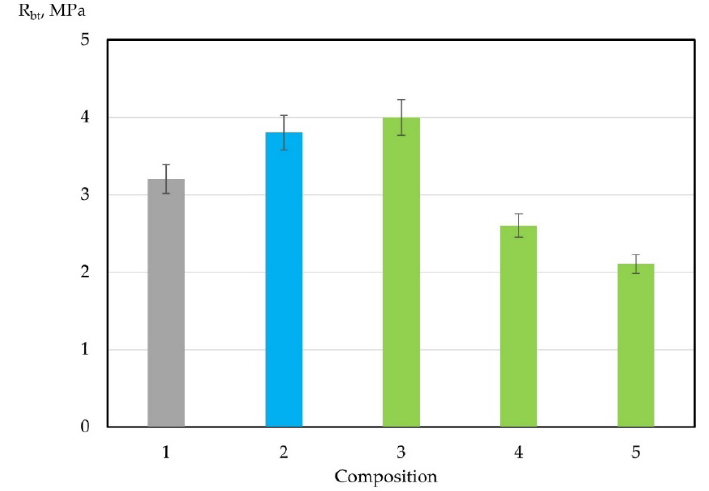
Figure 8. Change in axial tensile strength of concrete samples at the age of 28 days: 1 (grey)—control composition; 2 (blue)—electromagnetically treated cement paste without RSA; 3, 4, 5 (green)— electromagnetic treated cement paste with RSA of different dosage according to Table 6.